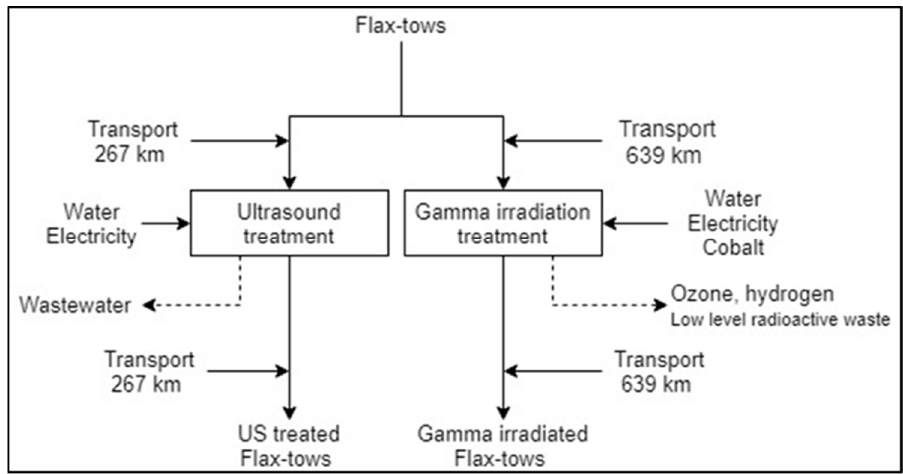
Figure 2. Flow chart for ultrasound and gamma irradiation pre-treatments.